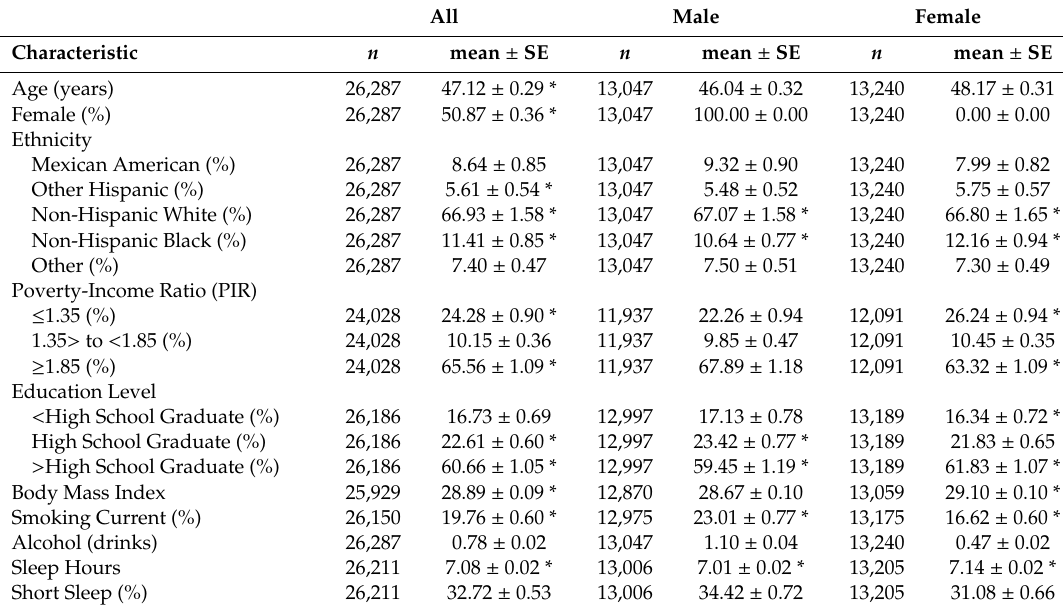
Table 1. Demographics of the study